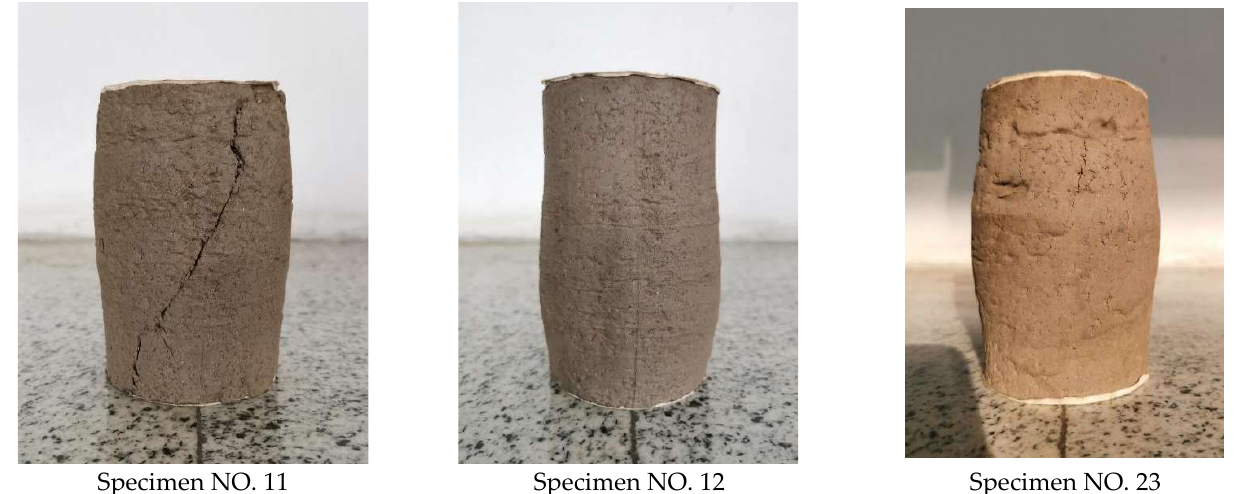
Figure 14. Appearances of tested specimens going through 4 FTHs.